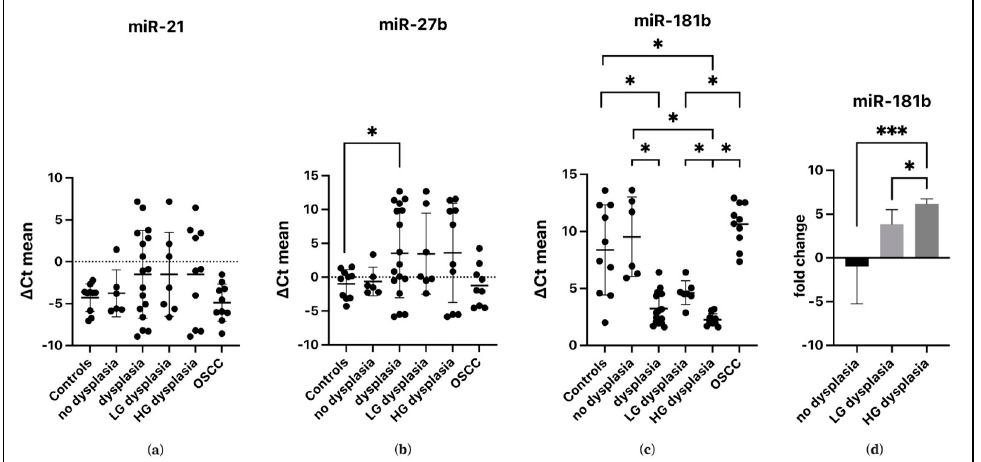
Figure 1. Salivary miRNAs expression in OED, ND, OSCC groups and in Controls. Subgroups HG and LG dysplasia were added. The Δ Ct mean of all salivary samples from patients for each miRNA is represented ( a – c ). The fold change of miR-181b within the OPMD group is reported ( d ). Asterisk = the comparison between groups, is significant for * p ≤ 0.05, *** p ≤ 0.001. Cancers 2022 , 14 , x FOR PEER REVIEW